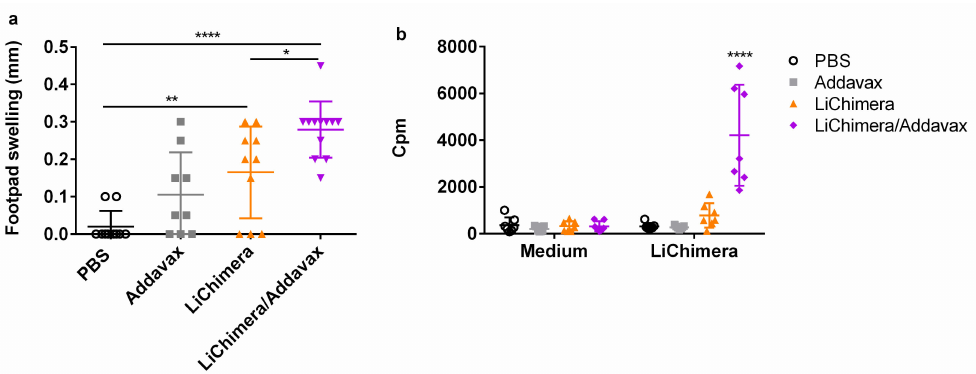
Figure 5. Detection of cellular immune responses following LiChimera vaccination. The BALB / c mice were intramuscularly vaccinated two times at two-week intervals with LiChimera alone or adjuvanted with Addavax. ( a ) Delayed-type hypersensitivity (DTH) responses were evaluated on day 10 post boosting by measuring the di ff erence between the thickness of the test and control footpads at 24 h post injection; ( b ) Spleens were collected two weeks post boosting and splenocytes were stimulated in vitro with LiChimera (2.5 µ g / mL) for 72 h. Antigen-specific splenocyte proliferation was determined by [ 3 H]-thymidine incorporation after another 18 h of culture and expressed as counts per minute (cpm). Data are expressed as means ± s.d. for n = 6 (PBS and Addavax) or n = 8 mice (LiChimera and LiChimera / Addavax). Significant di ff erences between groups are indicated with asterisks measured by one-way ANOVA and Tukey’s multiple comparison tests. * p < 0.05, ** p < 0.01, and **** p <